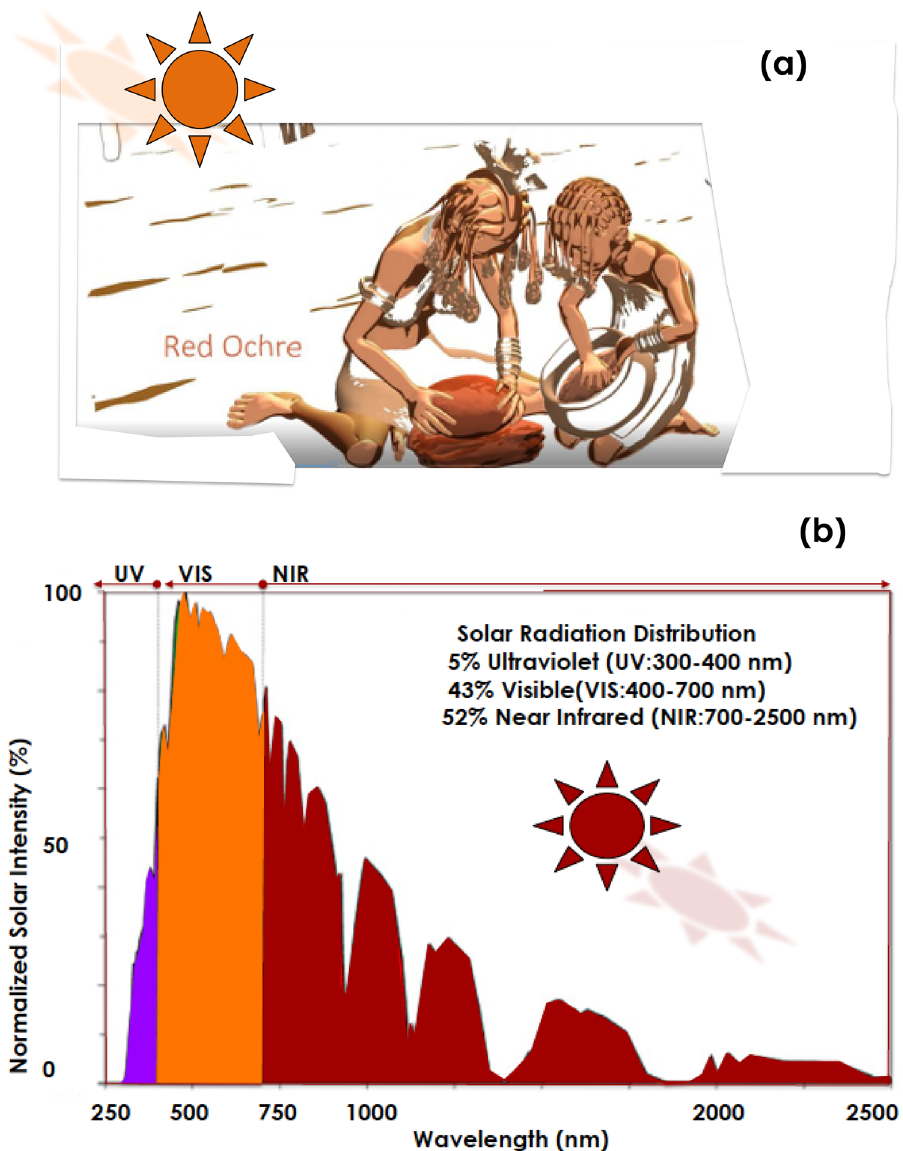
Figure 1. ( a ) Traditional preparation of the Red Ochre pigment by the Himba community, ( b ) Solar spectral distribution in the north of Namibia to which the Himba group community is